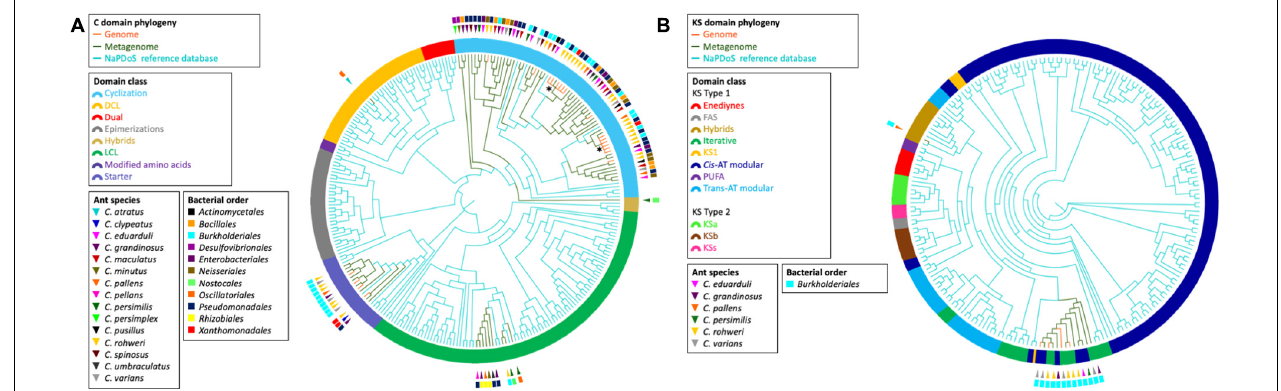
FIGURE 4 | Phylogeny of retrieved C and KS elongation domain sequences in the NRP and PK assemblies, respectively. The phylogenies were inferred from the C domain sequences (A) and the KS domain sequences (B) from the Cephalotes bacterial genomes (orange branches) and metagenomes (green branches) with the NaPDos reference database (blue branches). The ring surrounding the tips represent the C domain class or KS domain class. The bacterial order from which each domain sequence was retrieved is indicated by the colored rectangle. The ant species associated with each sequence is indicated by the colored triangle. The symbol * designates the clade of the two C domain sequences found in the NRP phylogenetic reconstruction (see Figure 3